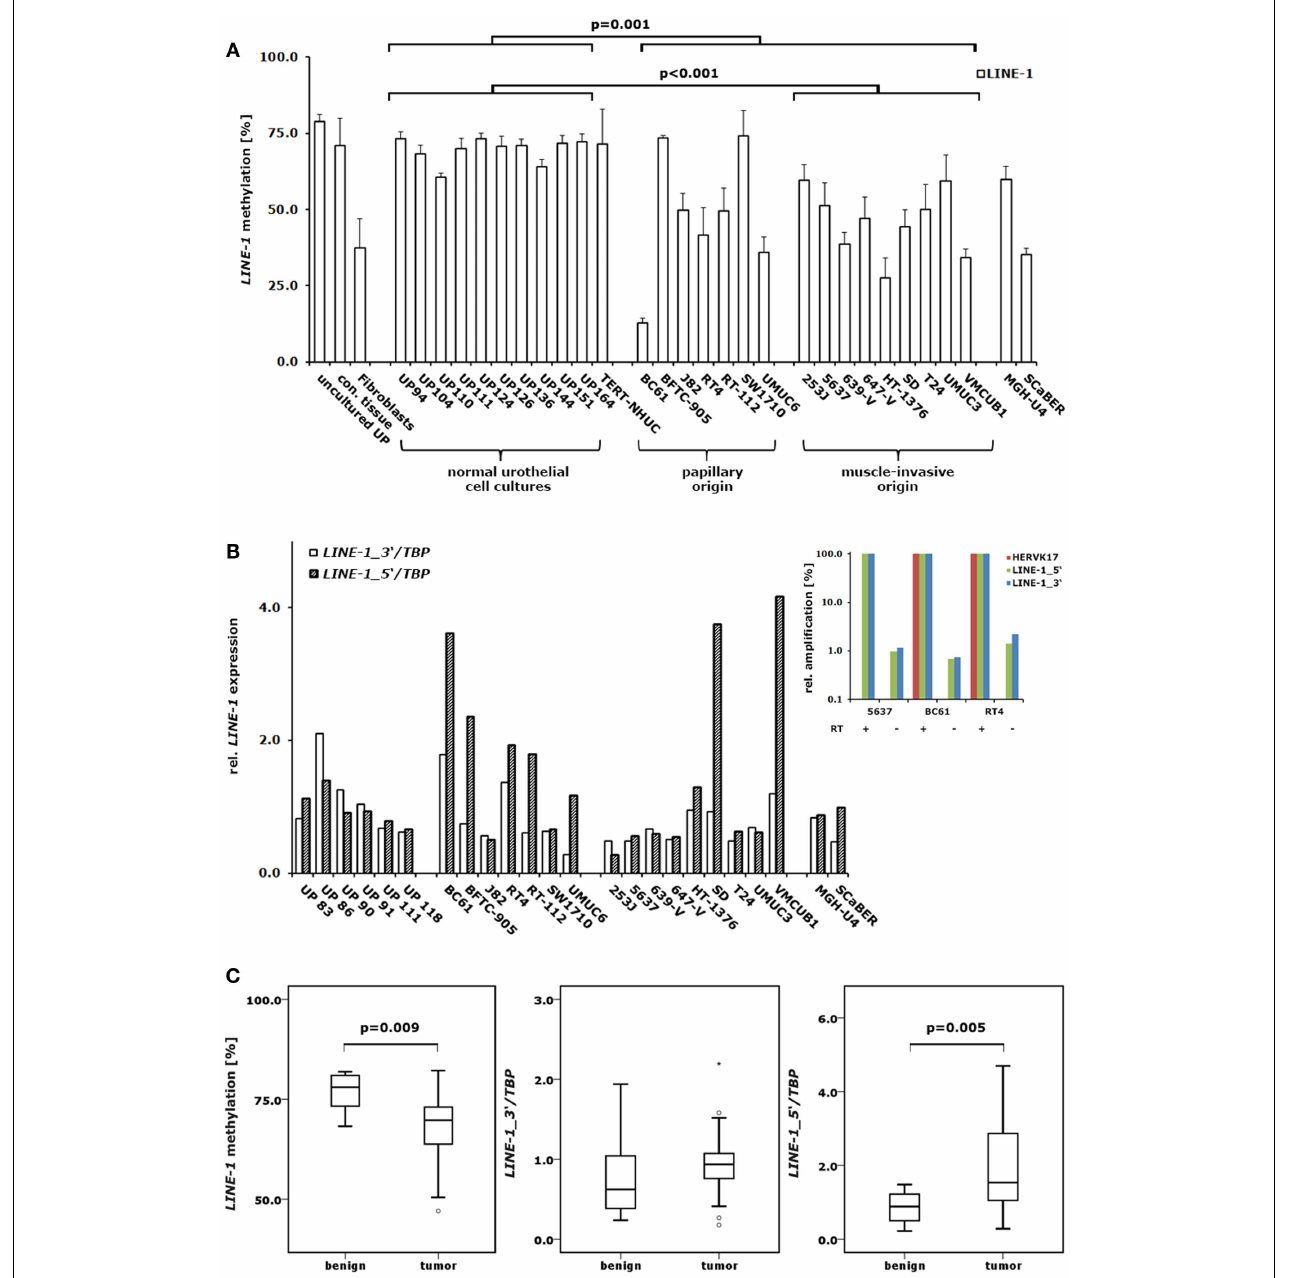
impact of genomic DNA contamination. Results were adjusted for each assay and cell line to reverse transcriptase positive preparations set as 100% (C) LINE-1 DNA methylation and expression of the 5 (cid:48) - and 3 (cid:48) -regions were analyzed in a set of 12 benign and 23 cancerous bladder tissues or 11 benign and 24 tumorous bladder tissues, respectively. Methylation is plotted as mean methylation value from four CpGs in percent (A,C) . RNA levels were each normalized to TBP and standardized to either the median RNA level of normal urothelial cell cultures (B) or the median RNA level of benign bladder tissues (C) set as 1. p Values calculated by the Mann–Whitney U -test were given above the brackets for significant changes ( p < 0.05). Missing p values demonstrate changes without reaching the level of